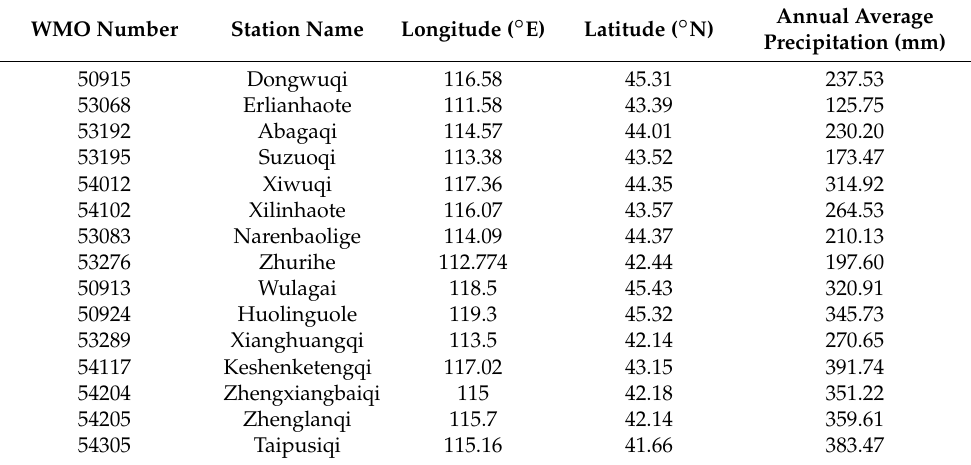
Table 1. List of the selected meteorological stations in study area.